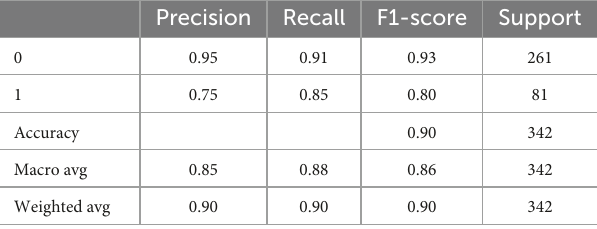
TABLE 6 LR model quality after optimization.